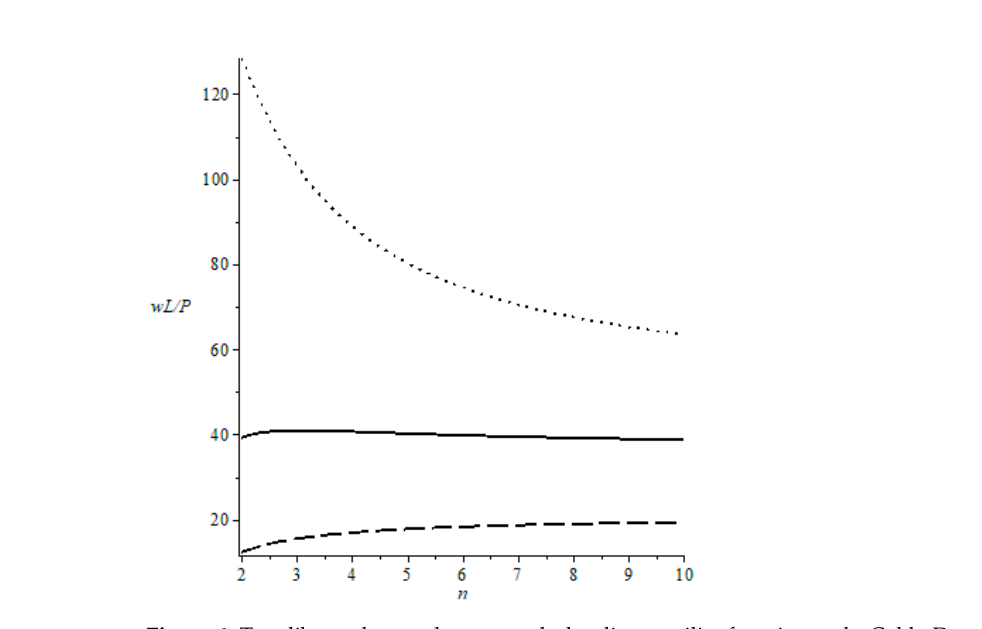
Figure 6. To calibrate the graphs, we used a log-linear utility function and a Cobb–Douglas production function with the following parameter values: q = 0.8, A = 20, β = 0.009, and α = 0.65 (dotted line); α = 0.3 (dashed line); and α = 0.53 (solid line).